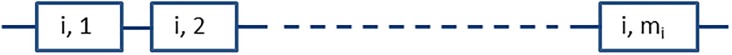
Failure by the ith path at time t requires mi independent failures to occur in any order, with the last failure at time t (Eq 5).